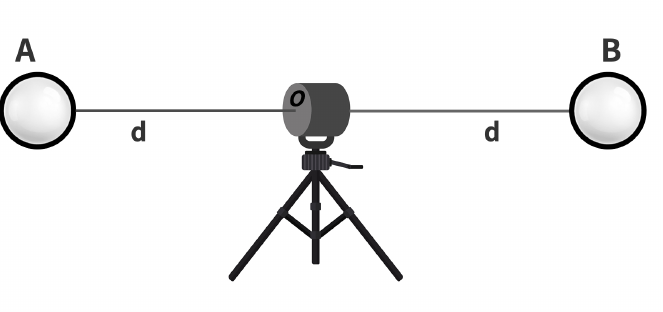
Figure 7. Inside Test layout. The distance d of both spheres A and B from the DUT shall be equal.